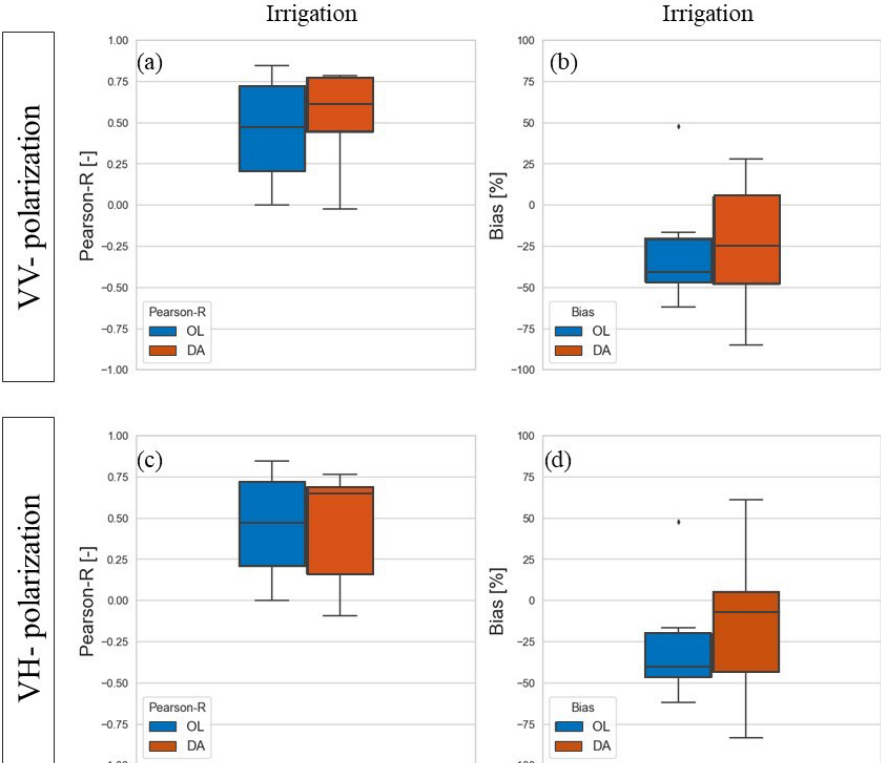
Figure 8. Evaluation in terms of (a, c) Pearson R and (b, d) percentage bias of irrigation simulations for the German test sites, containing the 8 irrigated LIS pixels with percentage irrigated area larger than 25%. Blue boxplots refer to the OL run, while orange boxplots refer to the DA run, with (a–b) the Sentinel-1 γ 0 VV DA and (c–d) for the Sentinel-1 γ 0 VH